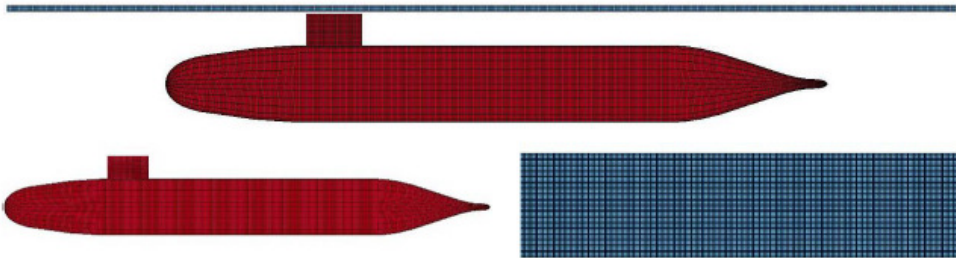
Figure 4. Submarine-Ice Plate Finite Element